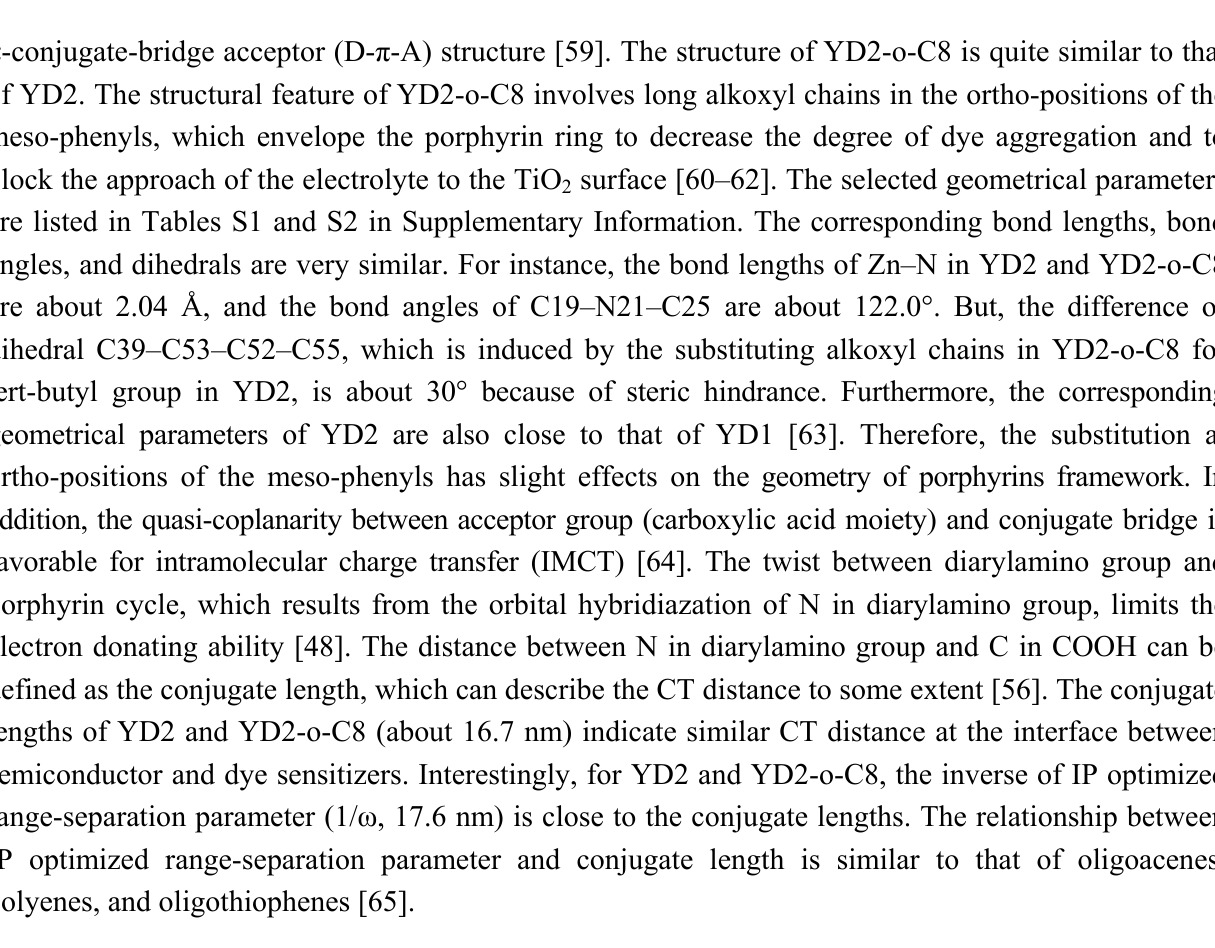
Figure 1. The optimized geometrical structures of YD2 and YD2-o-C8 (Hydrogen atoms have been omitted for clarity; gray circles: C; blue circles: N; red circles: O; light blue circles: Zn).